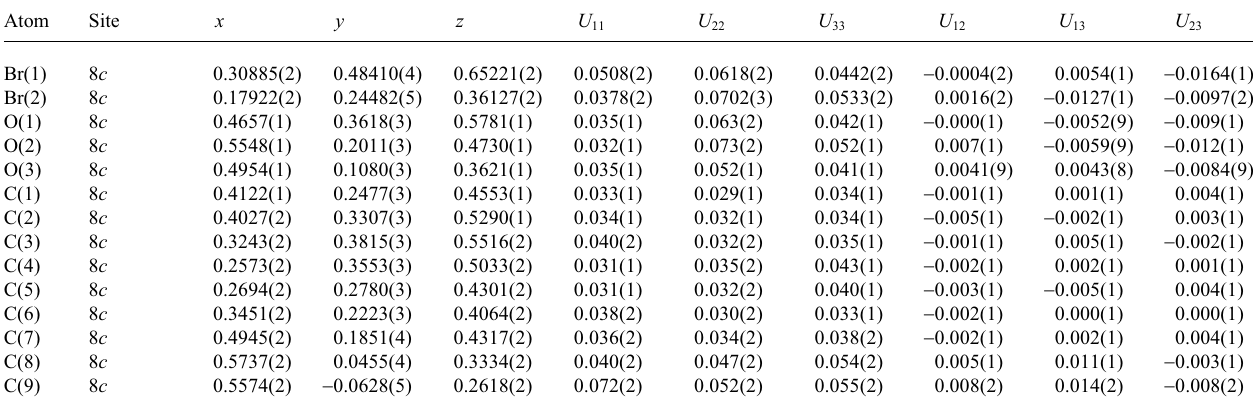
Table 3. Atomic coordinates and displacement parameters (in Å 2 )